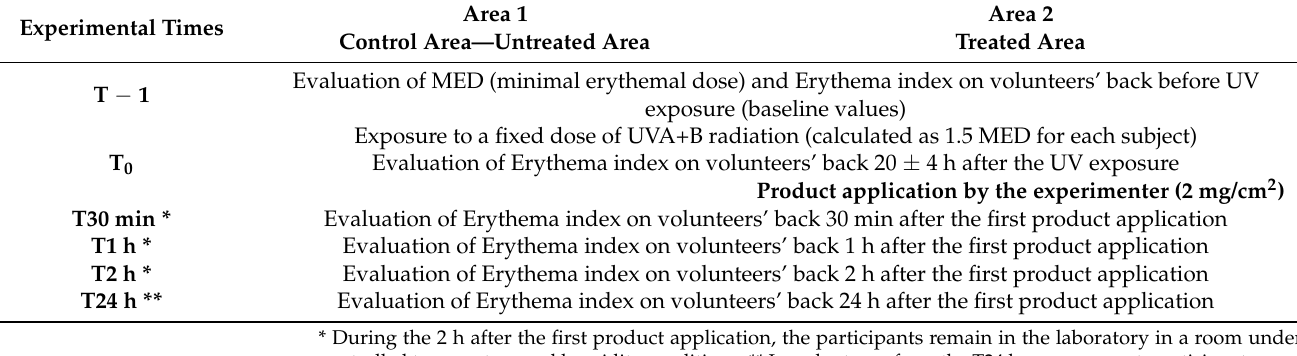
Area 2 Treated Area